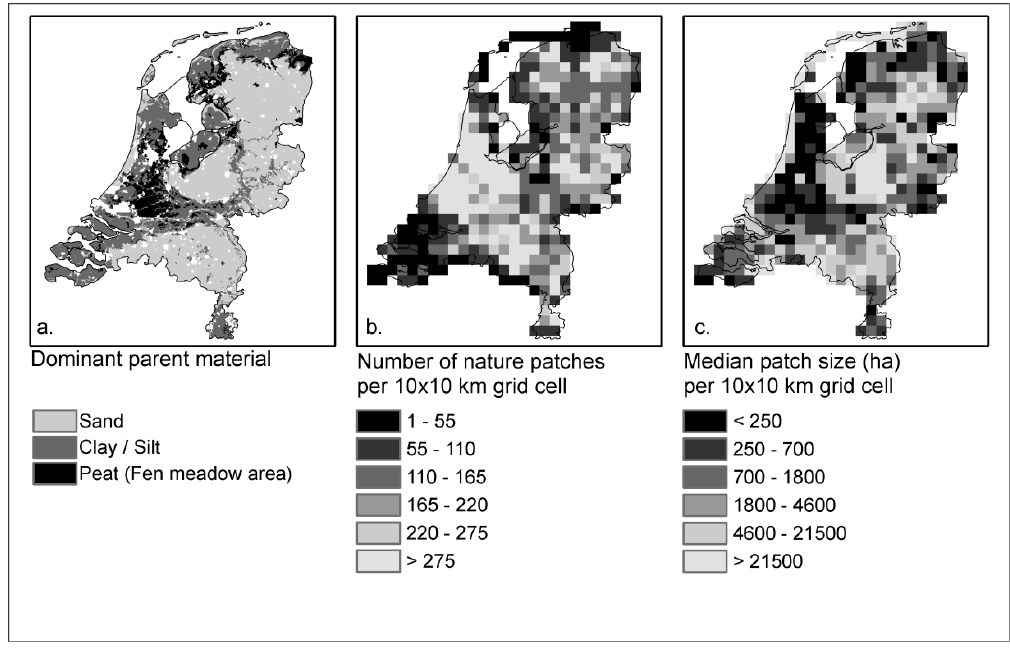
Figure 2. Landscape characteristics of the Netherlands.